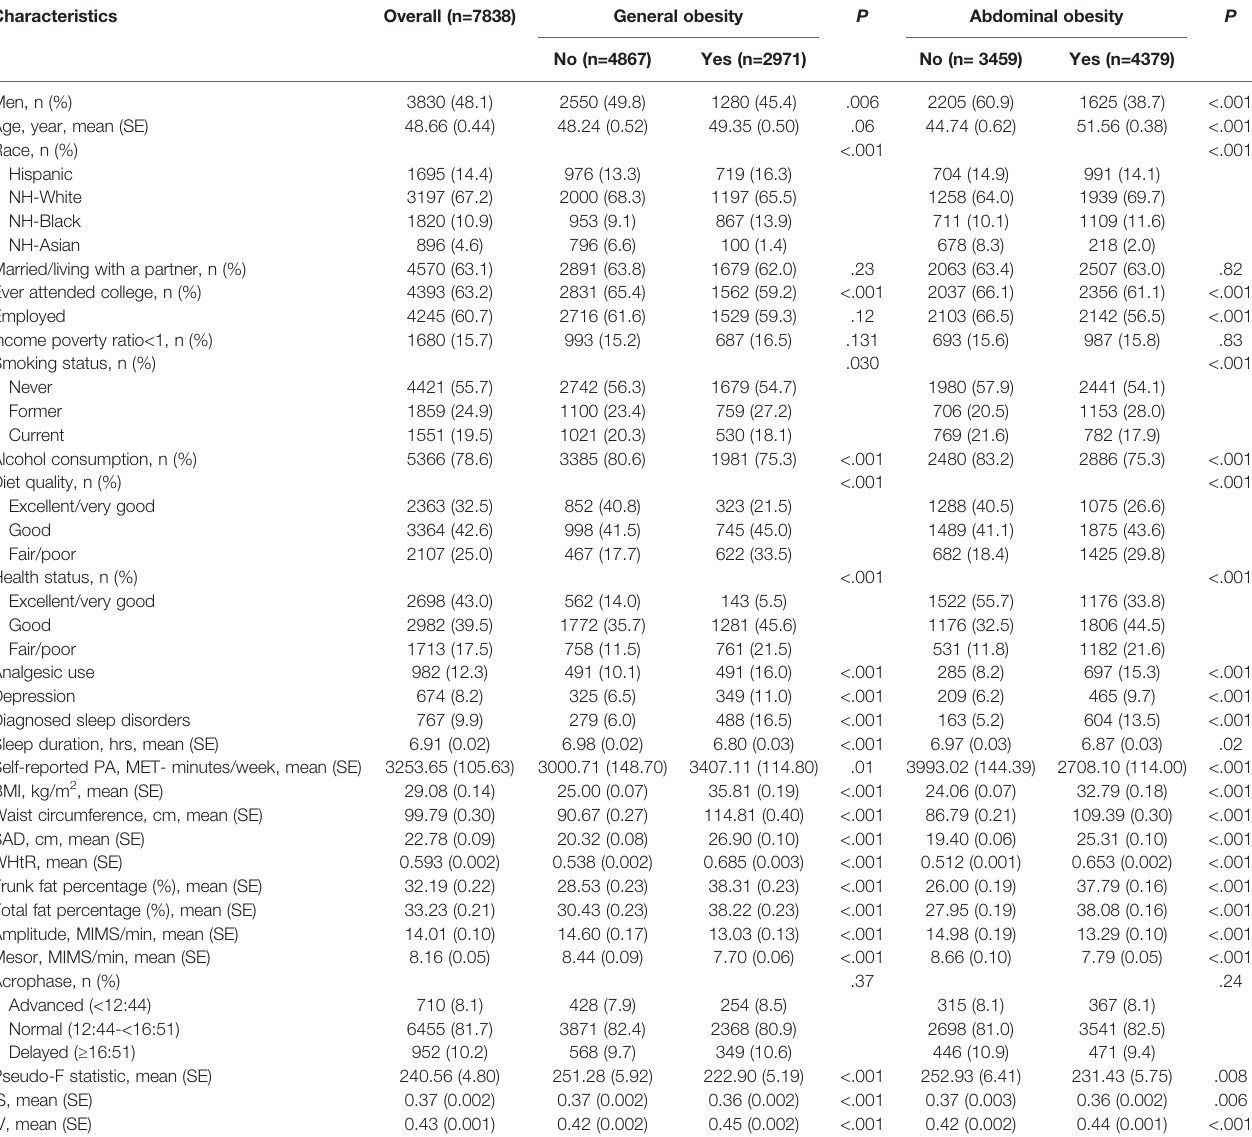
TABLE 1 | Participant characteristics and RAR metrics according to general and abdominal obesity status. Characteristics Overall (n=7838) General obesity P Abdominal obesity